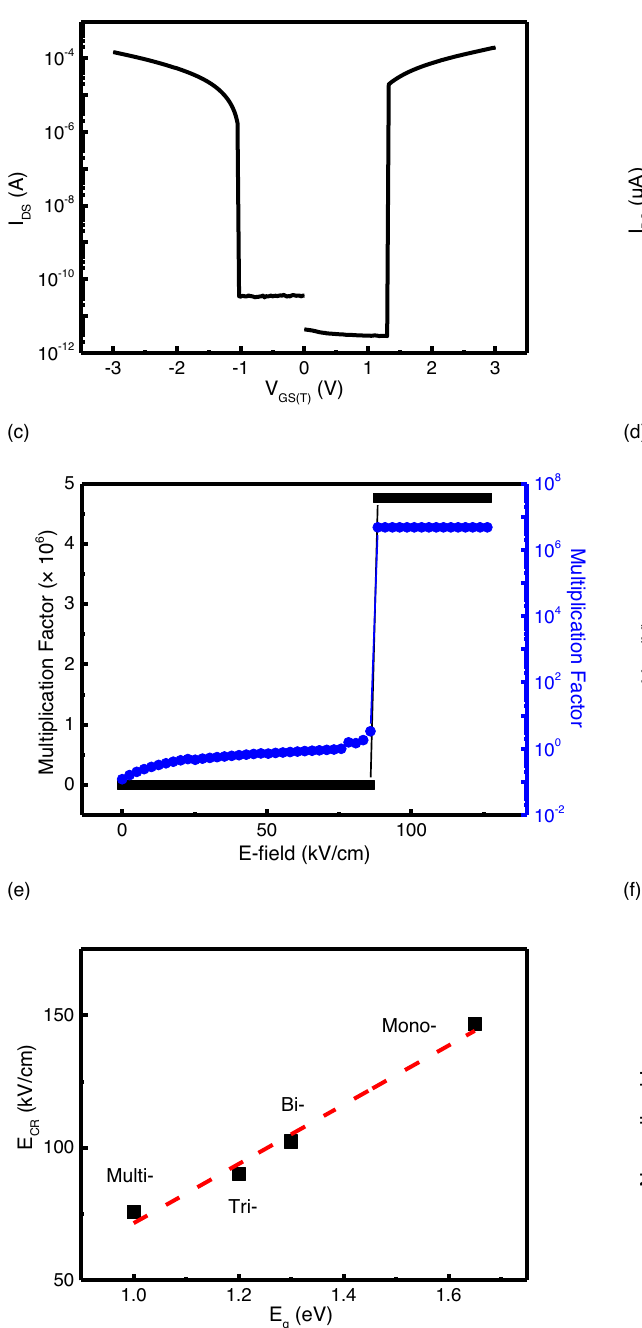
Fig. 3 | Electrical characteristics of WSe 2 I 2 FET. a Transfer curve and b output curveexhibitingsteepswitchingtransitionviaimpactionization. I DS saturatesinthe low-E- fi eld region owing to the insulating ungated region, whereas it increases abruptly in the high-E- fi eld region (shown by a log scale and linear scale plotted using blue and blacklines, respectively). c Calculated multiplication factor( M ) asa function of electric fi eld. d Calculated V BR and E CR of WSe 2 I 2 FETs vs. various